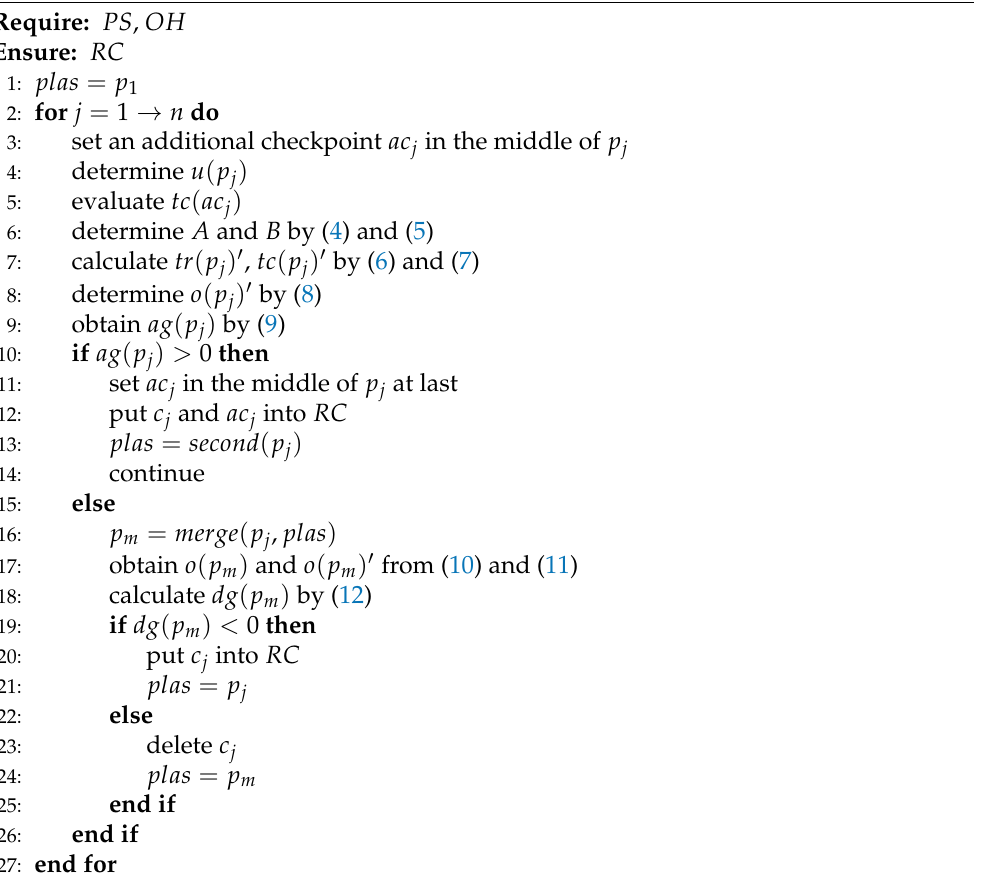
Algorithm 2 The Processes of the Last Two Parts of